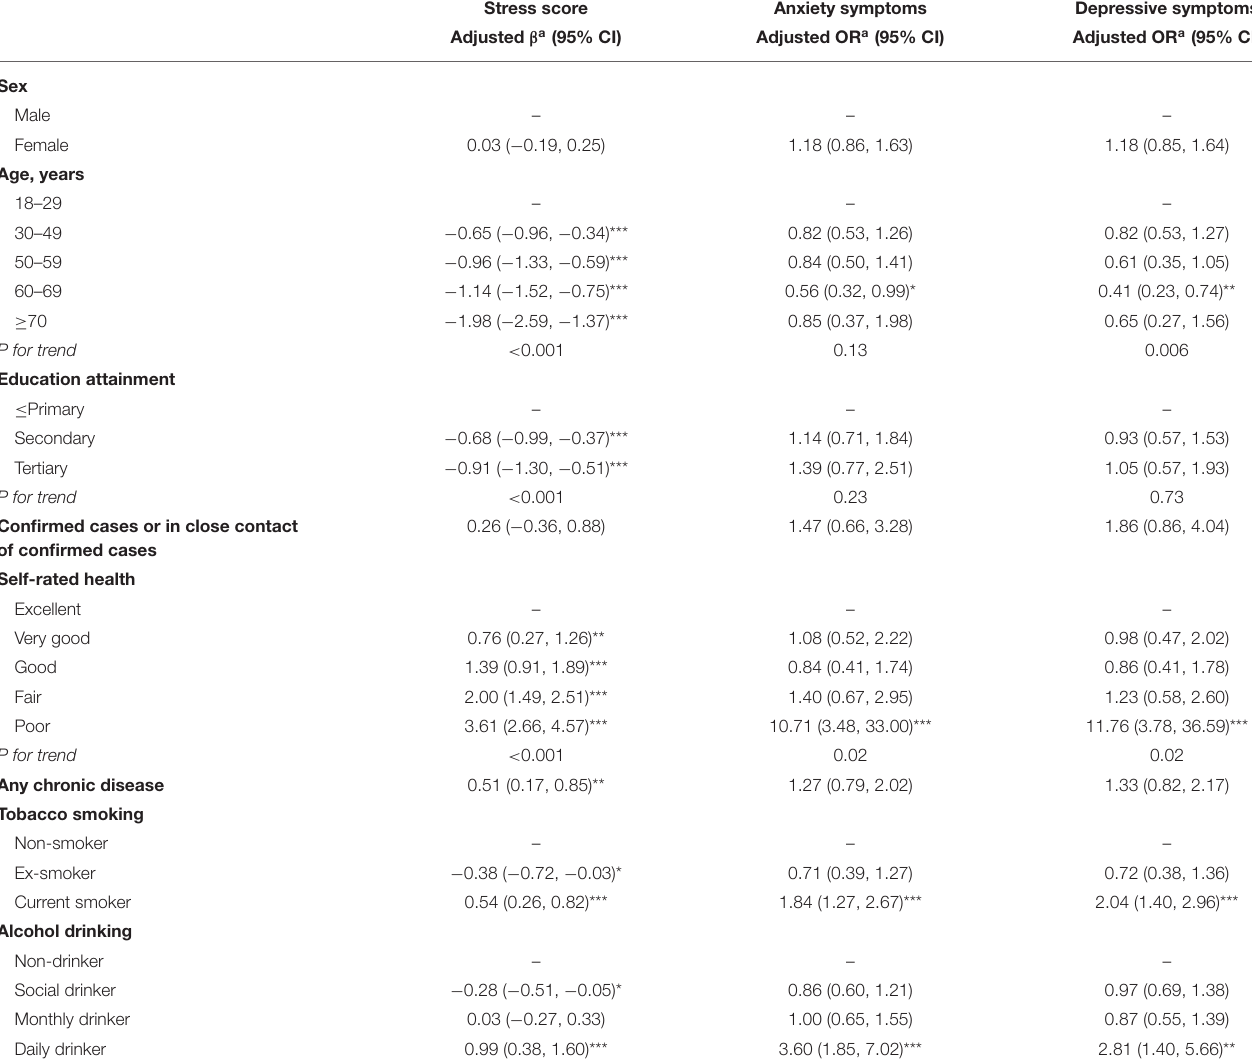
TABLE 3 | Mental health symptoms by sociodemographic factors, self-rated health, chronic disease, tobacco smoking, and alcohol